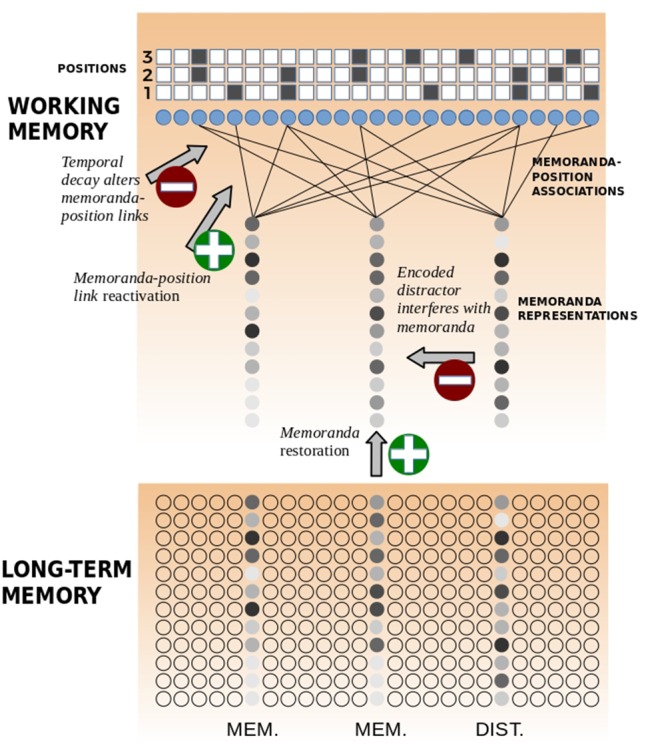
TBRS∗-I architecture.